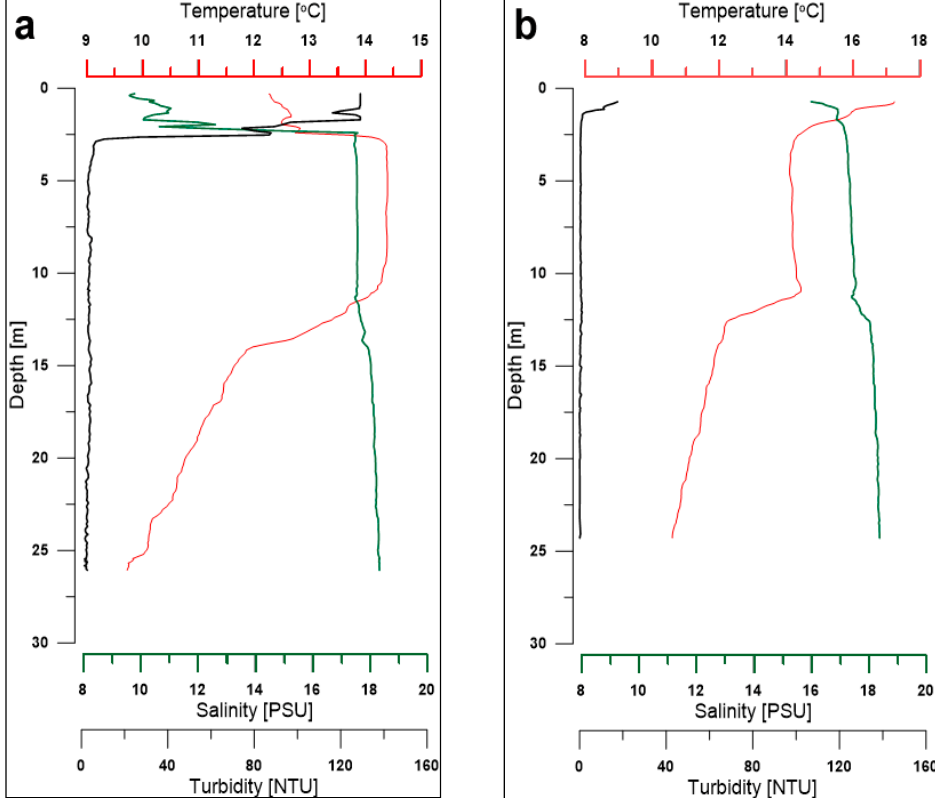
Figure 5. Typical CTD + TM casts: ( a ) Station 119 — the closest to the mouth; ( b ) Station 134 — near plume boundary (see Figure 4). Red line — temperature, green line — salinity, black line — turbidity.